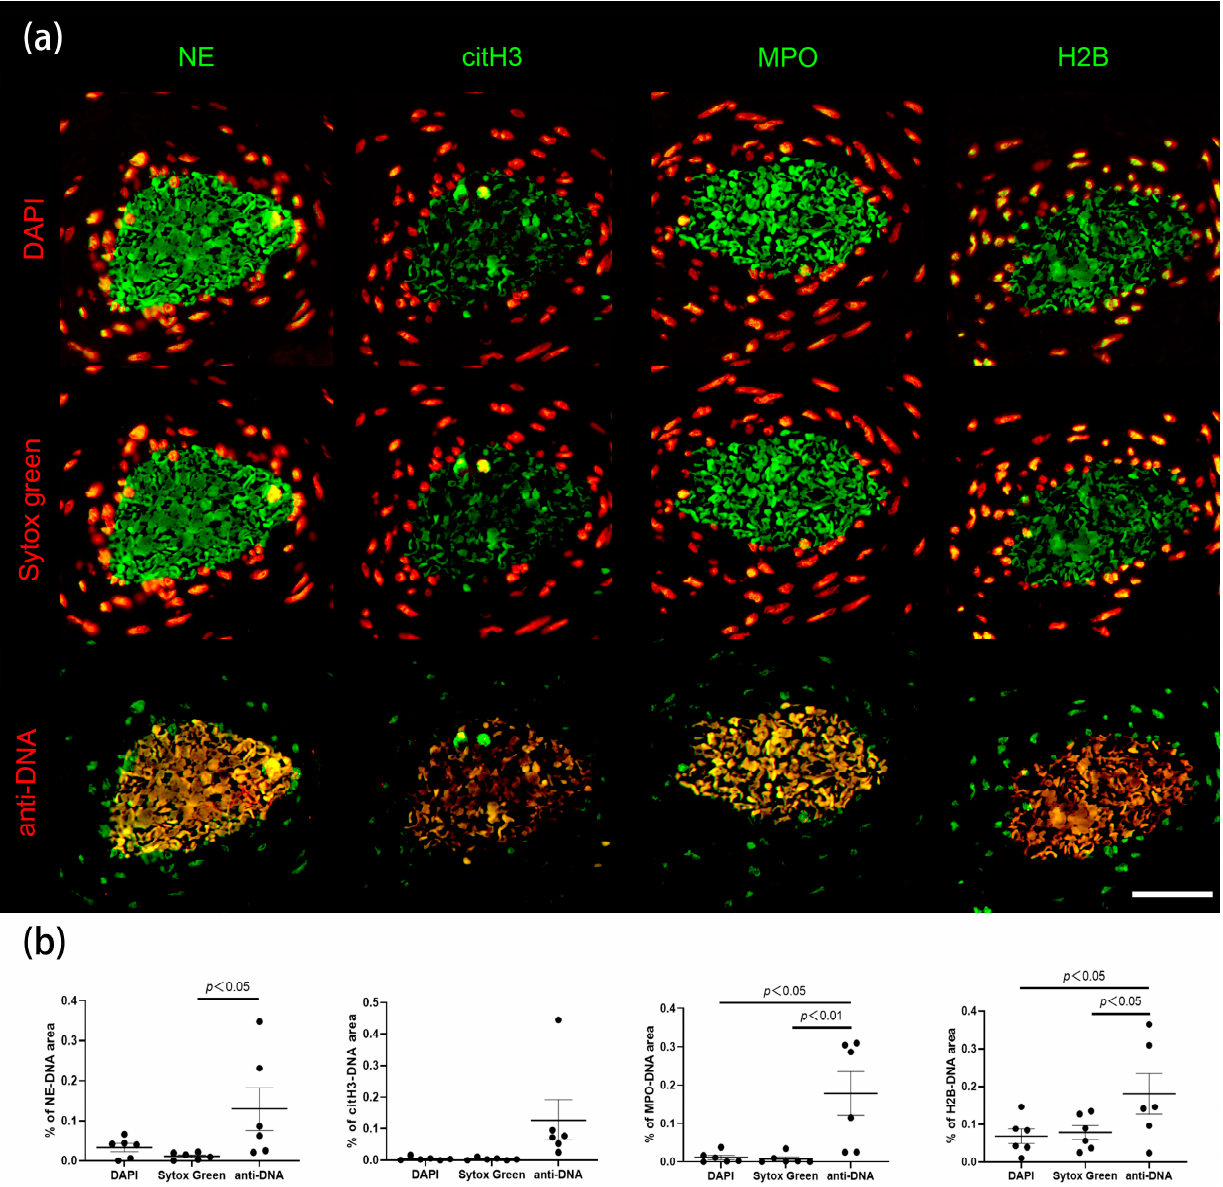
Figure 5. Immunofluorescence staining and quantification of NETs in tissues from COVID and colon tumor patients. ( a ) DNA is stained using DAPI (red, first row), SYTOX™ Green (red, second row) and anti-DNA-IgM (red, last row). NETs-associated proteins are stained using anti-NE-IgG (green, first column), anti-citH3-IgG (green, second column), anti-MPO-IgG (green, third column) and anti-H2B-IgG (green, last column). Scale bar = 50 µ m. ( b ) Measurement of co-localization area ratio of tissue sections in six spots, N = 2. Data were presented as mean ± SEM. p < 0.05 is significant.